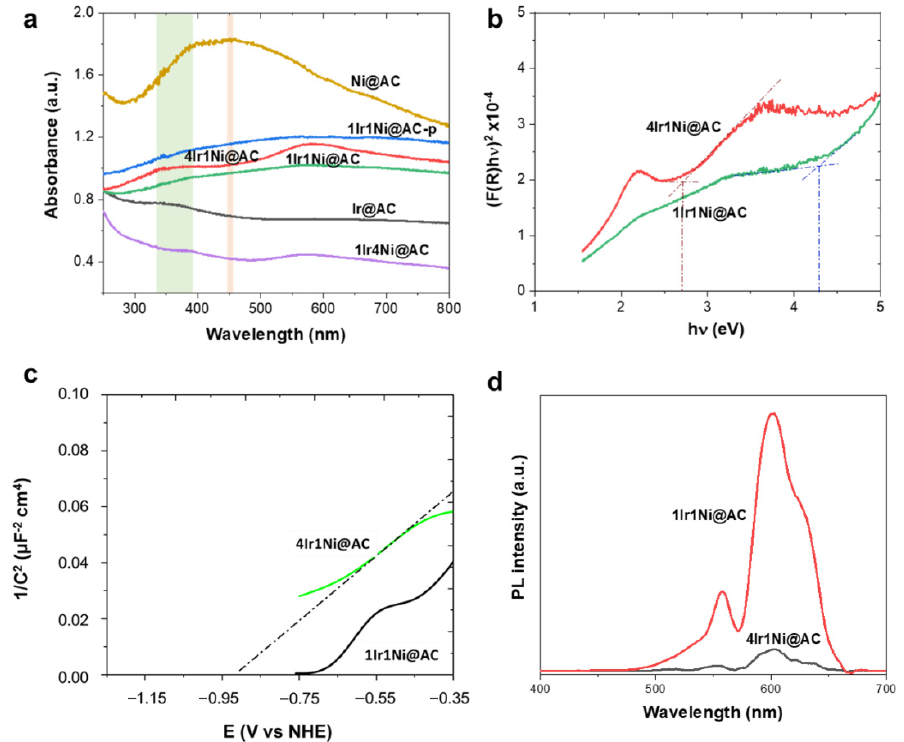
Figure 4. ( a ) UV–visible absorbance spectra of all metal and alloy combinations used in this study: shaded area at 330–380 nm reflects characteristic peak position for IrO 2 and shade at 455 nm is for NiO, ( b ) Tauc plot, ( c ) Mott–Schottky plot, and ( d ) PL emission spectra obtained upon excitation with light in the 350 nm range.